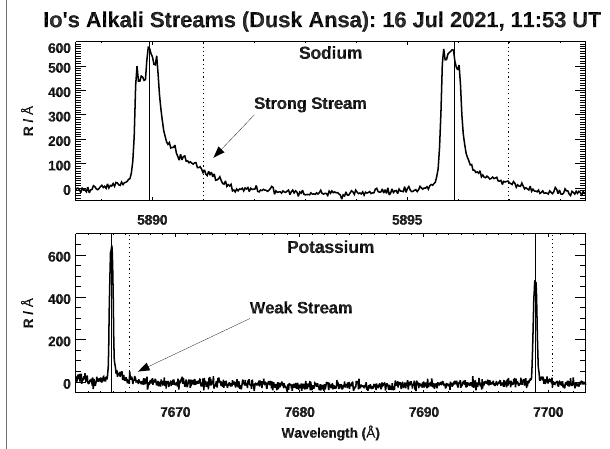
FIGURE 4 | Keck HIRES spectrum of Na and K D emission at the dusk ansa ofthe Ioplasma torus, showing Doppler structure.Spectral fl ux here has units of Rayleighs/Å. The Keplerian velocity is shown in the solid lines, and the co-rotational velocity of the jovian magnetosphere is shown as the dotted lines. Pointing trails Io, which is at 330 ° orbital longitude. The red- shifted stream ofNa atoms is due to ion neutralization (Na jet). Absence of this feature in the K line pro fi les suggests the potassium reaction is less ef fi